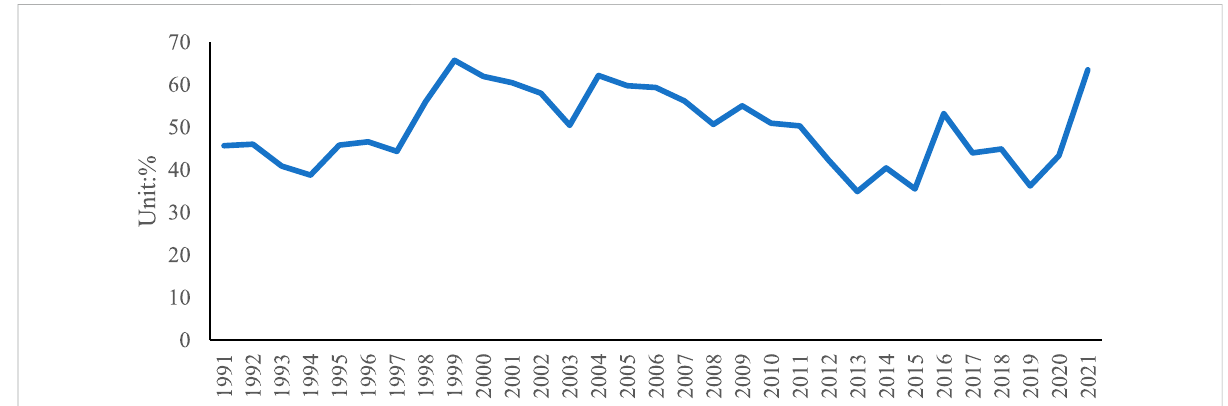
FIGURE 1 TheproportionofTaiwanesefundedenterprisesinvestinginheavilypollutingindustriesinChinesemainlandduring1991and2021.Note:Figure is based on the data from “ Taiwan ’ s Investment Board of Ministry of Economic Affairs ” . According to the Guidelines for Environmental Information Disclosure of Listed Companies issued by the Ministry of Ecology and Environmental of the People ’ s Republic of China in 2010, mining industry, chemical manufacturing, chemical materials, plastic products, metal products, electronic components, computers, electronic products, and optical products, textile industry, leather, fur and their products, and pulp, paper, and paper products are regarded as heavy pollution